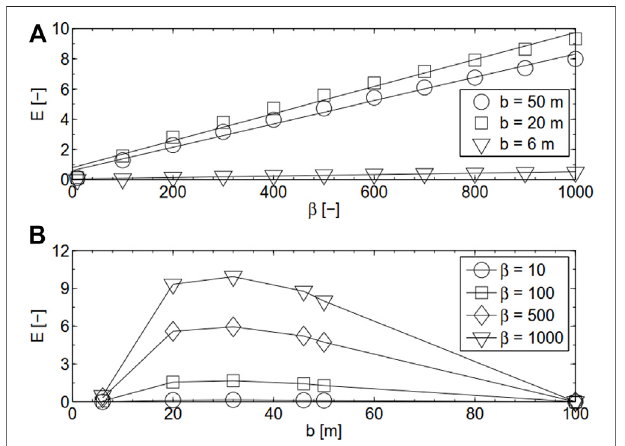
FIGURE 8 | (A) Sensitivity of E to β for b = 6, 20, and 50 m, and (B) sensitivity of E to b for β = 10, 100, 500, and 1,000.